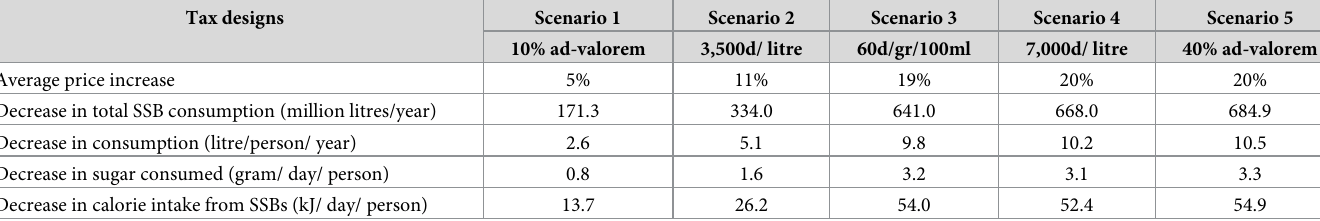
Table 3. Changes in SSBs’ consumption in five SSB tax